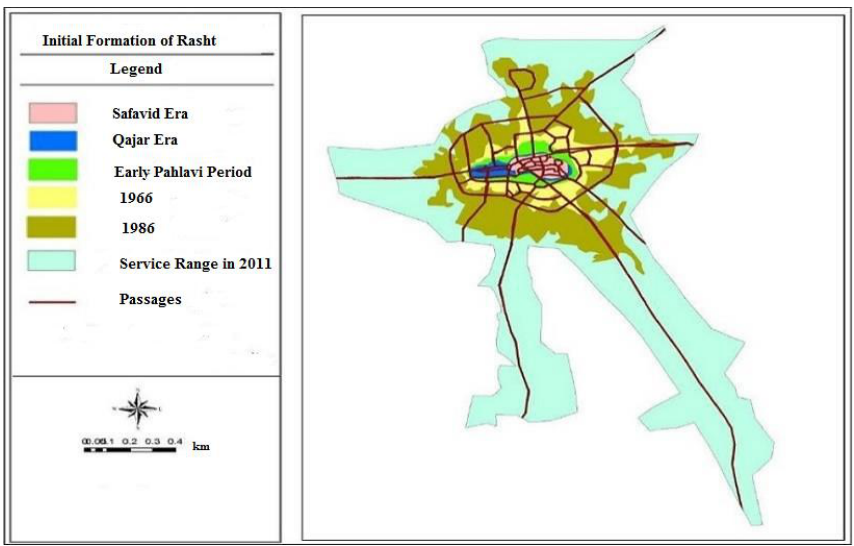
Figure 1. The plan of initial formation of Rasht in different eras